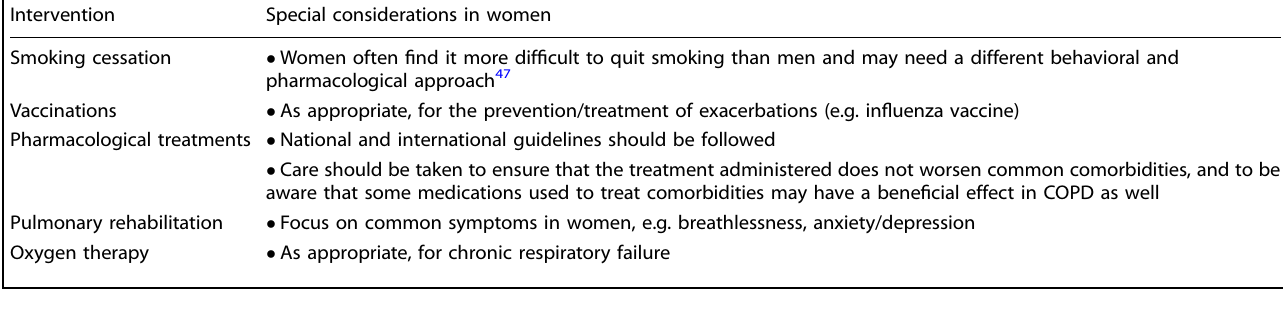
Table 3. Educating women about their COPD for better disease control Topic Special considerations in